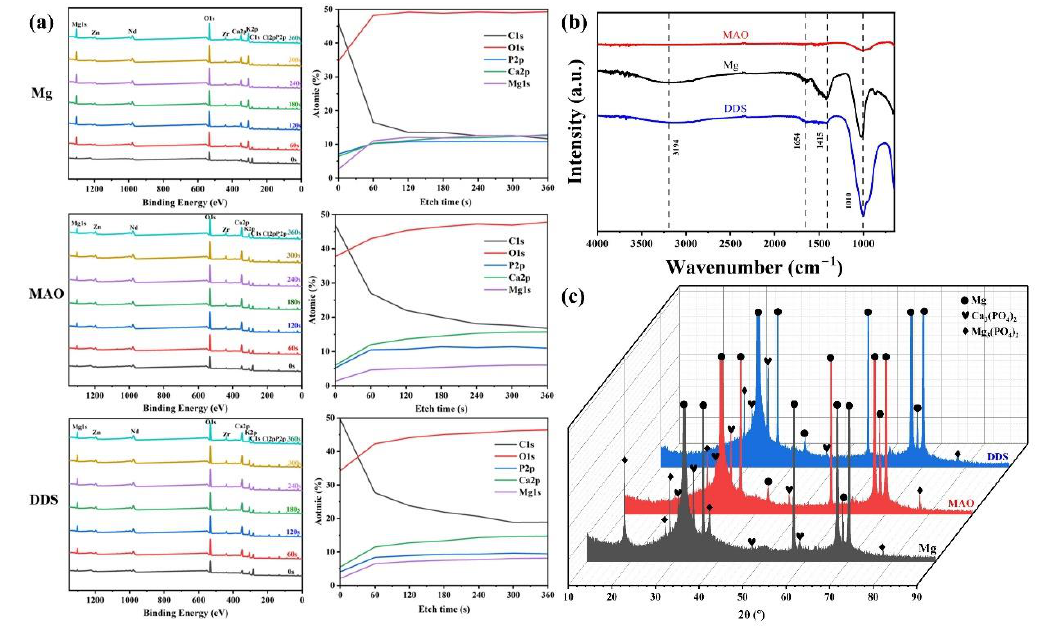
Figure 7. XPS patterns ( a ), FT-IR ( b ) patterns, and XRD patterns ( c ) of Mg alloy, Mg-based MAO alloy, and Mg-based MAO-MT- PLGA DDS after immersion in Hank’s solution for 28 days.